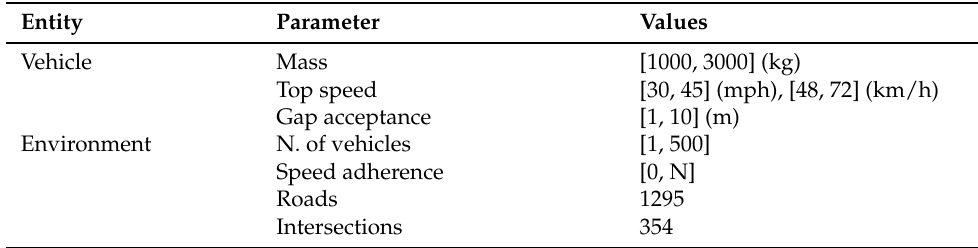
Table 1. Model entities and parameter values (source: